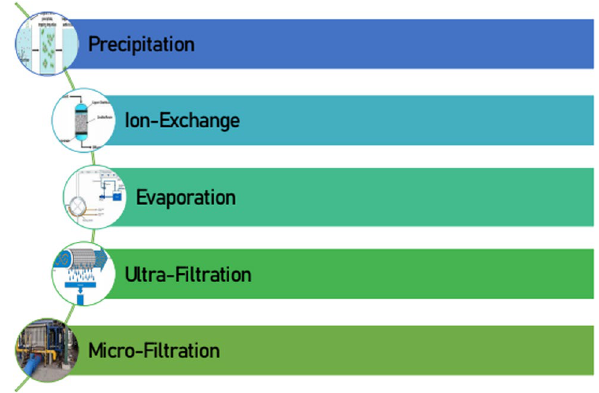
Fig. 3 Methods in reduction of nuclear liquid Table 1 Waste water effluent analyses of the electric power plants (data provided in this table has been updated)